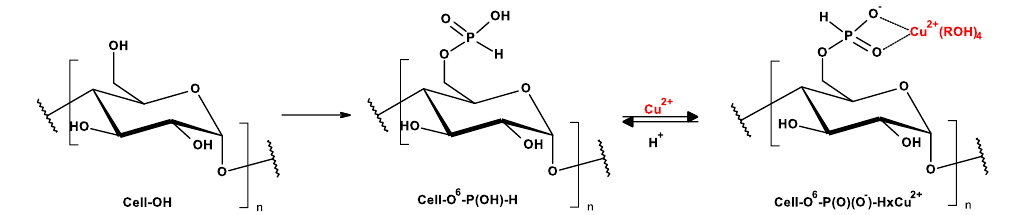
Figure 4. Synthesis of complexes of cellulose- O 6 -phosphates and copper ions (Cell- O 6 -P(O)(O − )-H → Cell- O 6 -P(O)(O − )-H × Cu 2+ ) (ROH- water molecules or cellulose hydroxyls).